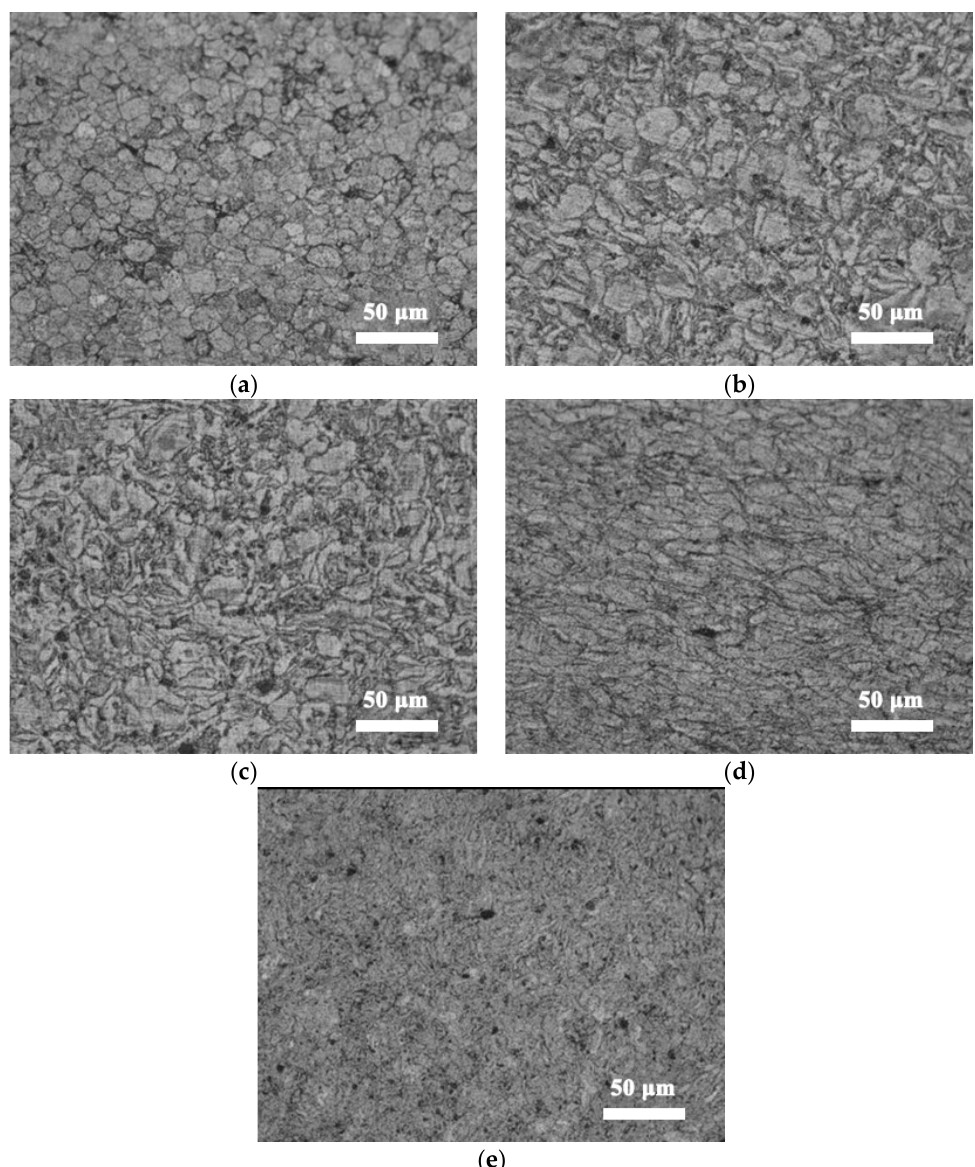
Figure 6. Microstructure of CNTs/Mg composites fabricated from Mg powder grinded for different times. ( a ) 0 h, ( b ) 15 h, ( c ) 30 h, ( d ) 45 h and ( e ) 60